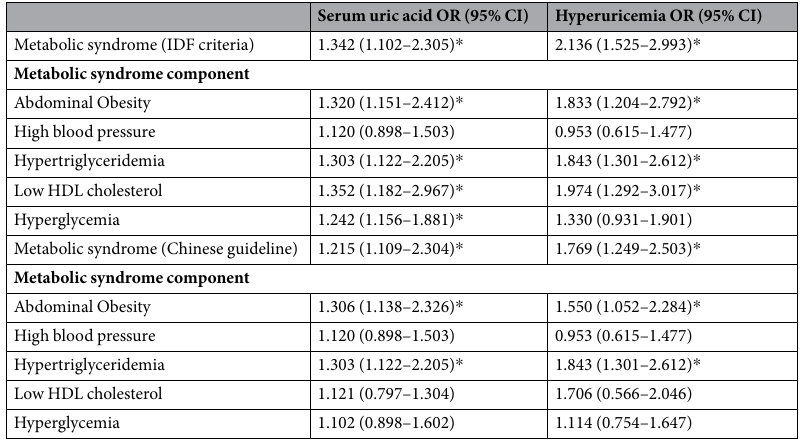
Table 3. Association between hyperuricaemia and metabolic syndrome using logistic regression models in community very elderly Chinese in Chengdu. Adjusted for sex, body mass index, low-density lipoprotein, eGFR, cigarette smoking, total cholesterol, low-density lipoprotein, alcohol consumption and medications for hypertension, diabetes mellitus, and hyperlipidemia. eGFR: estimated glomerular filtration rate. HDL: high- density lipoprotein, IDF: international diabetes federation. * p <